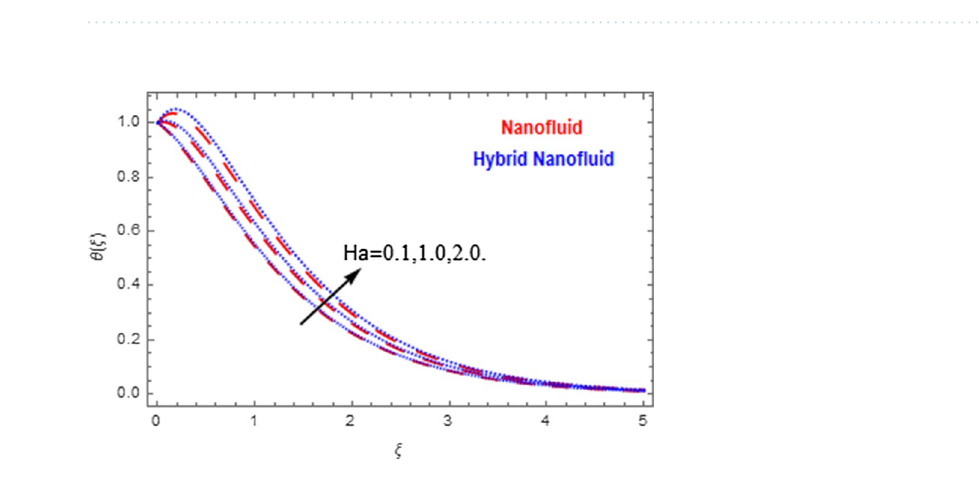
Figure 8. Variation in temperature field of nanofluid ( Al 2 O 3 ) and hybrid nanofluid ( Al 2 O 3 , Cu ) against different estimations of Ha